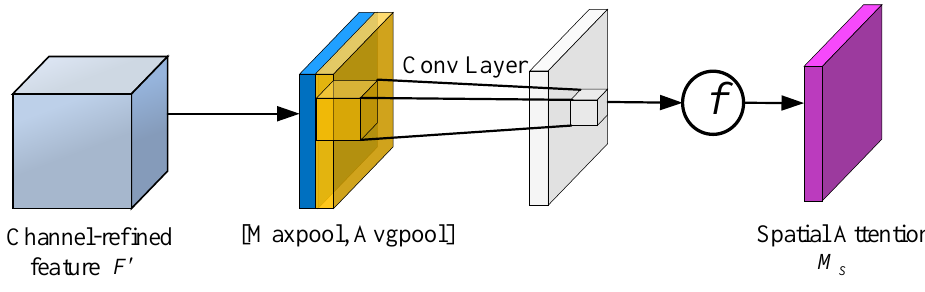
Figure 5. Spatial attention module .